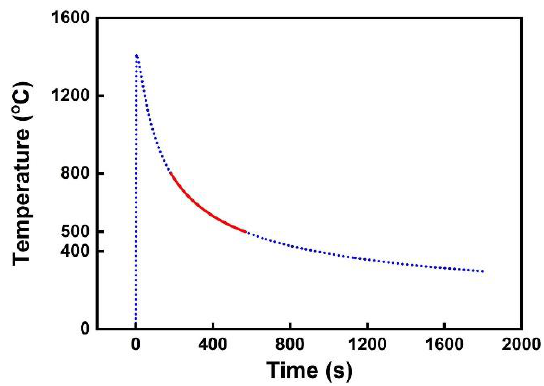
Figure 2. Thermal cycle for the simulation of the electrogas arc welding with a heat input of 400 kJ cm − 1 for the 50 mm-thick steel plates.